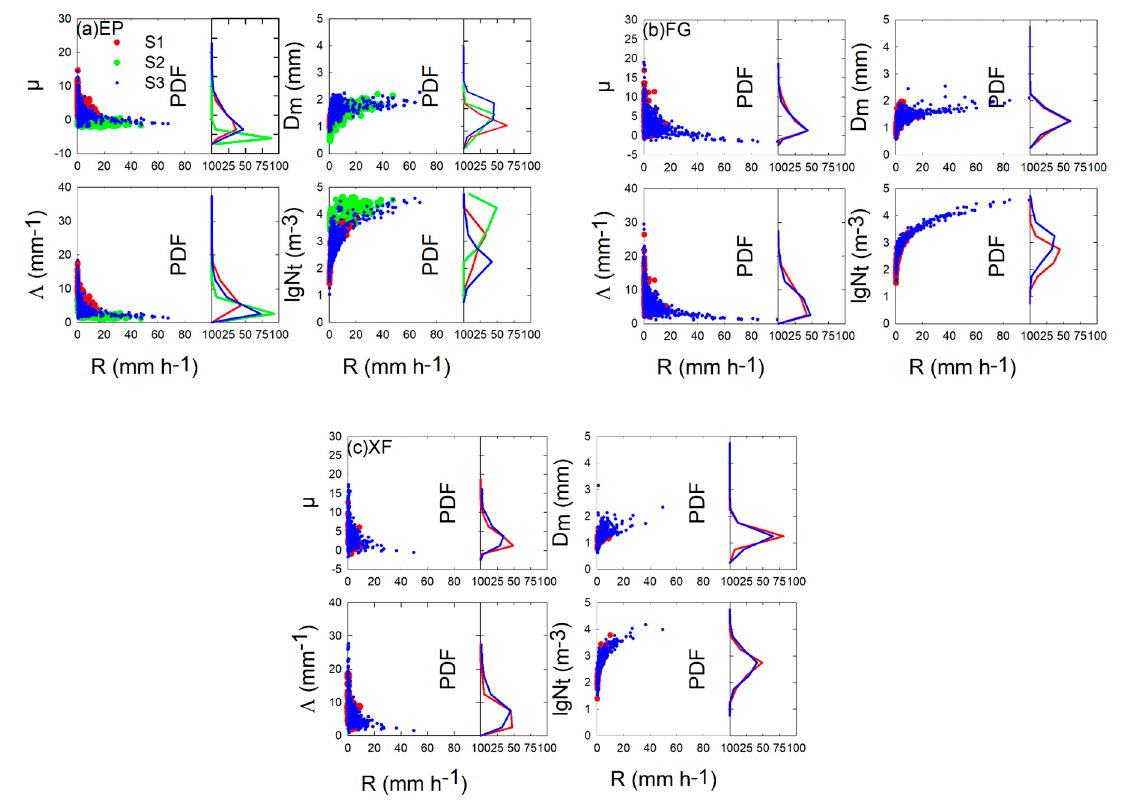
Figure 6. Scatterplots of µ , D m (mm), Λ (mm − 1 ), and lgN t (m − 3 ) versus R (mm h − 1 ) for the three segments at the ( a ) EP, ( b ) FG, and ( c ) XF sites. The probability density functions (PDF) of the four raindrop size distribution (DSD) parameters at the EP, FG, and XF sites are given in each panel as well. Segments S1, S2, and S3 are shown as red dots, green dots, and blue dots, respectively.